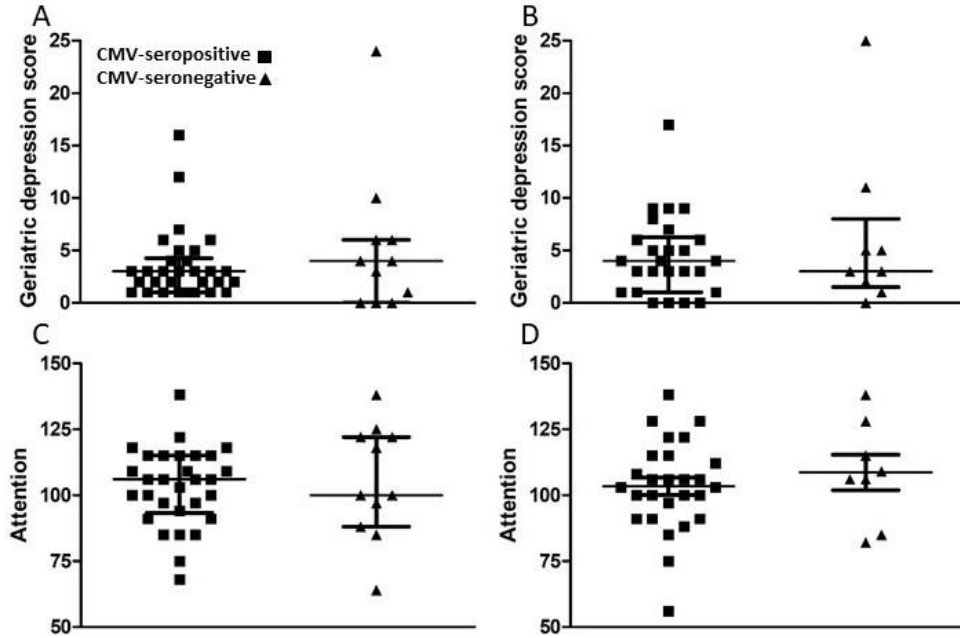
Figure 4. Comparison of geriatric depression and attention scores between groups of CMV-seropositive and -seronegative subjects at t1 and t2. ( A , C ) Following neuropsychological testing, geriatric depression and attention scores were calculated at t1 for all study subjects and ( B , D ) approximately 18 months later (t2) for all study subjects completing follow-up. Error bars on graphs show median ± interquartile range for each group. No significant differences between CMV-seropositive and -seronegative groups were observed. Mann – Whitney U -test, ( A ) p = 0.766, ( B ) p = 1.000, ( C ) p = 0.605, ( D ) p = 0.442.